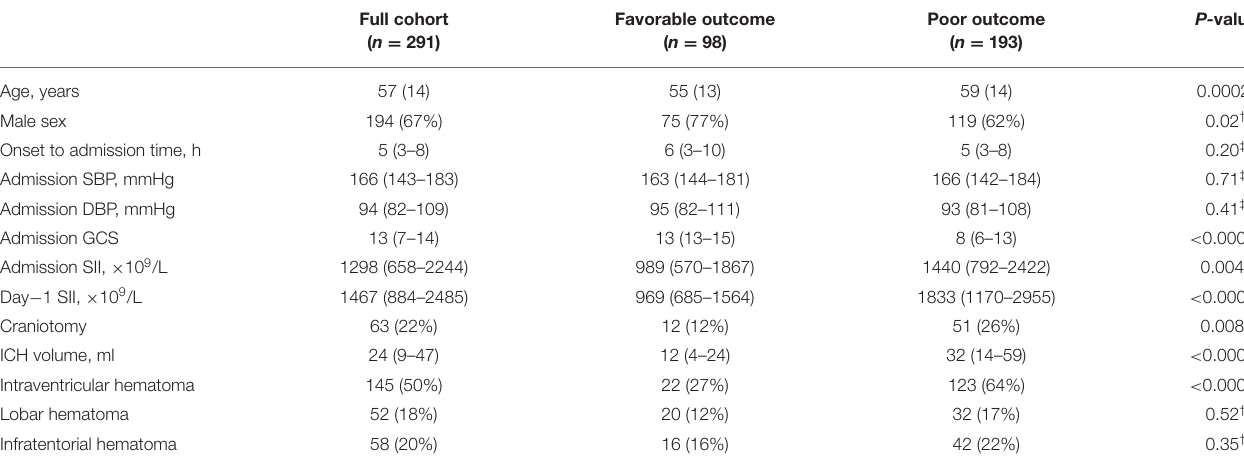
TABLE 1 | Baseline comparison between 90-day outcome groups.